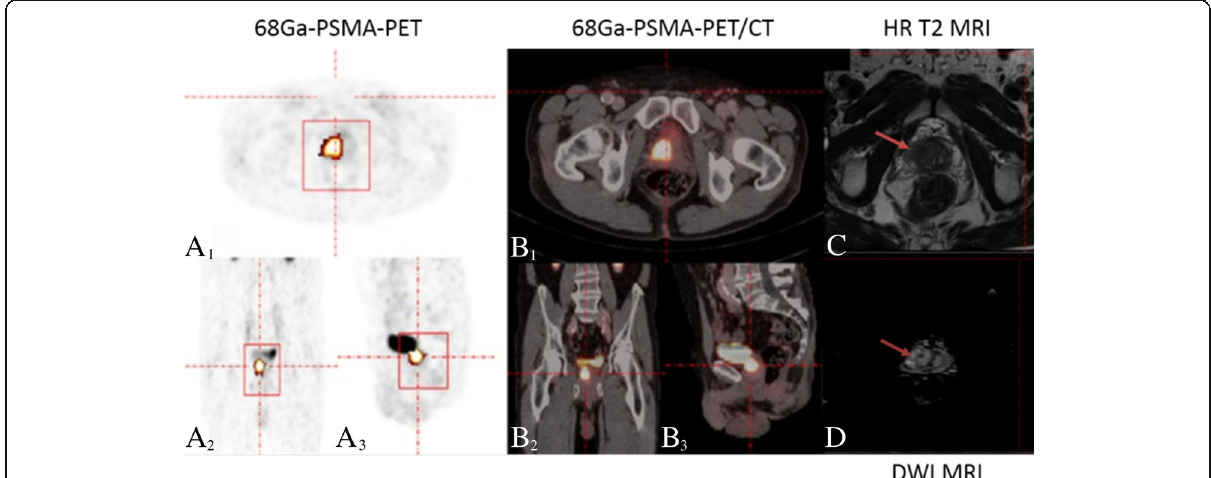
Fig. 2 Example of tumor heterogeneity for the asphericity assessment in a patient diagnosed with a Gleason score 9 prostate cancer. A – D Example of a patient diagnosed with a Gleason score 9 prostate cancer in the in the right peripheral zone of the midgland of the prostate. A , B Corresponding orientations (transversal ( A 1 ), coronal ( A 2 ), and sagittal ( A 3 )) are shown for 68Gallium-labeled prostate-specific membrane antigen positron emission tomography, fused with computed tomography ( B 1 – 3 ). Based on positron emission tomography, an avid heterogeneous tumor was delineated in all three planes using the rover software. C , D Corresponding magnetic resonance imaging in T2 turbo spin echo ( C ) and diffusion-weighted images ( D ) in axial images confirm the presence of the maligne lesion at the respective location. HR: high-resolution, DWI: diffusion-weighted